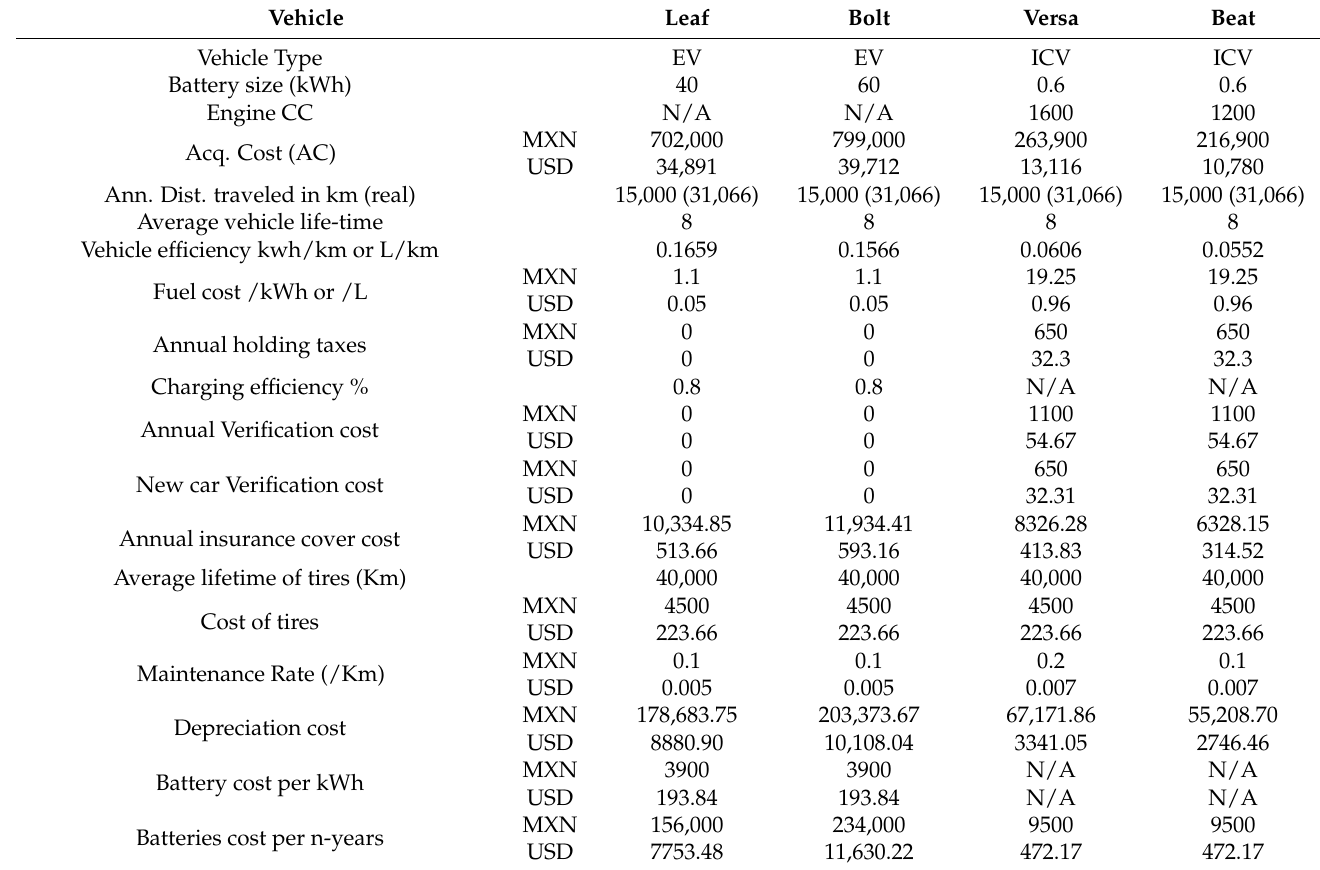
Table A1. Parameters used for LCC calculation.